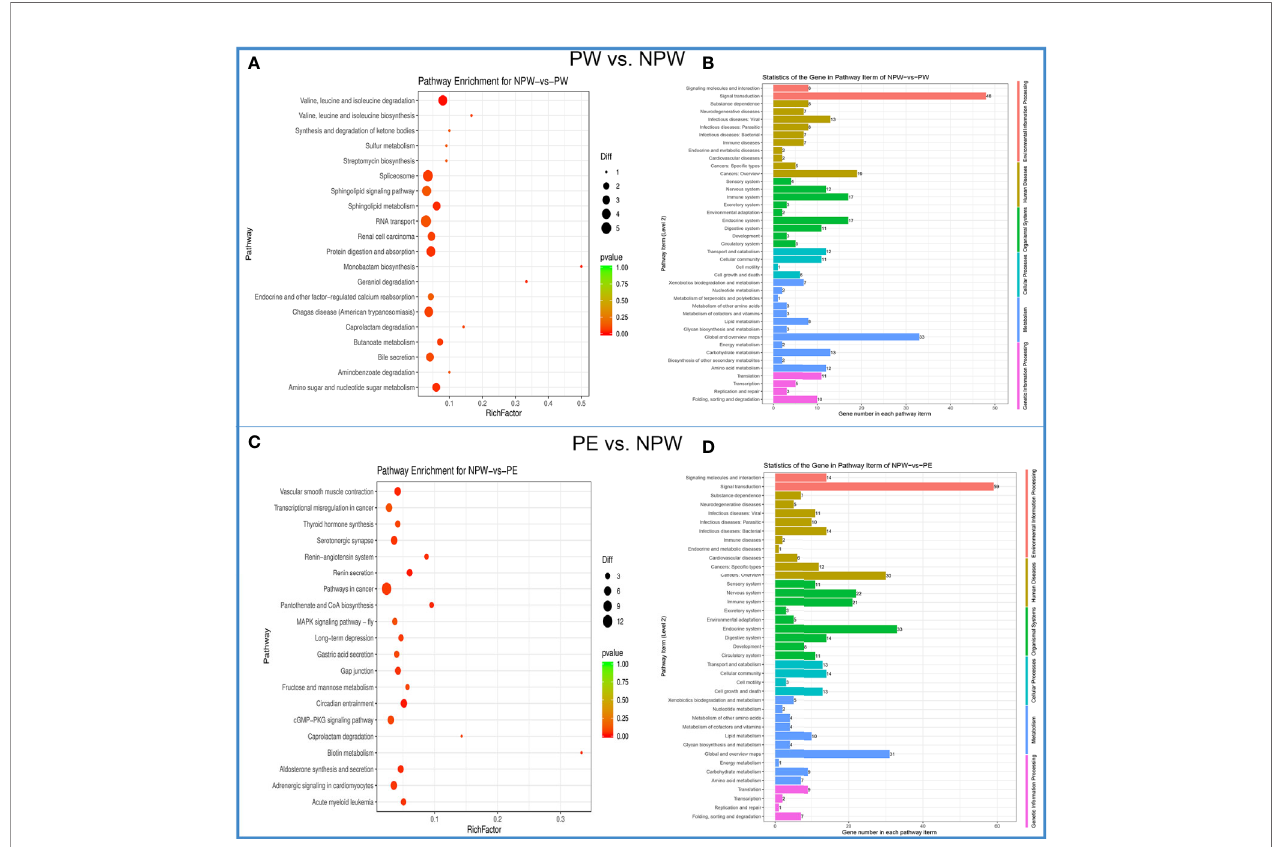
FIGURE 5 | Kyoto Encyclopedia of Genes and Genomes (KEGG) enrichment of DMGs in the PW and PE groups. (A) The scatter plot of the KEGG signaling pathway for PW vs . NPW. The ordinate represents the degree of enrichment, while the abscissa represents 20 KEGG signaling pathways. The black dots indicate the number of genes contained in the signal pathway, and the color of the dots represents the size of the P value. The reddish color indicates a stronger correlation. (B) KEGG signaling pathway histogram. The ordinate on the left represents 41 KEGG signal pathways, and the abscissa demonstrates the statistics of genes in each pathway term for PW vs . NPW. The ordinate in the left and color represents the different fi rst-level KEGG pathways. (C) The scatter plot of the KEGG signaling pathway for PE vs . NPW. The ordinate represents the degree of enrichment, while the abscissa represents 20 KEGG signaling pathways. The black dots indicate the number of genes contained in the signaling pathway, and the color of the dots represents the size of the P value. The reddish color indicates a stronger correlation. (D) KEGG signaling pathway histogram. The ordinate on the left represents 41 KEGG signaling pathways, and the abscissa demonstrates the statistics of genes in each pathway term for PE vs . NPW. The ordinate in the left and color represent the different fi rst-level KEGG